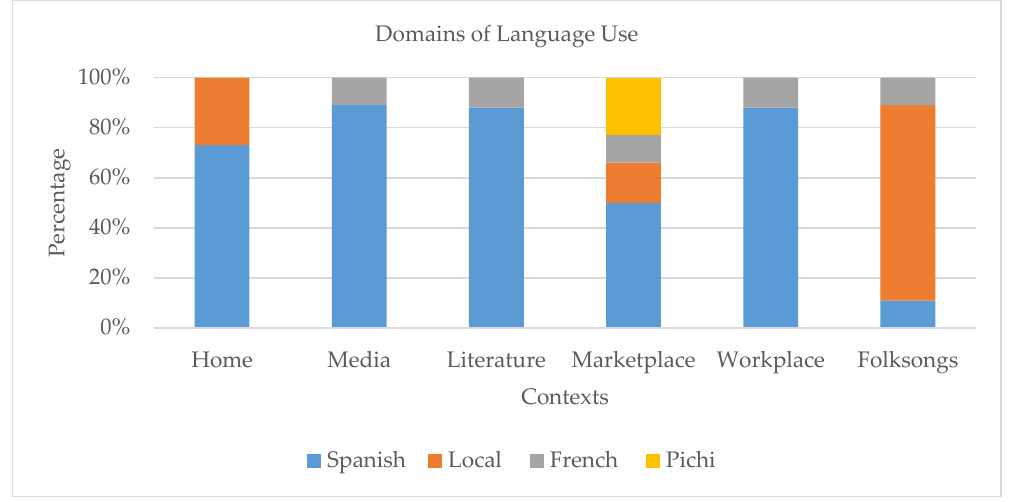
Figure 3. Domains of Language Use.